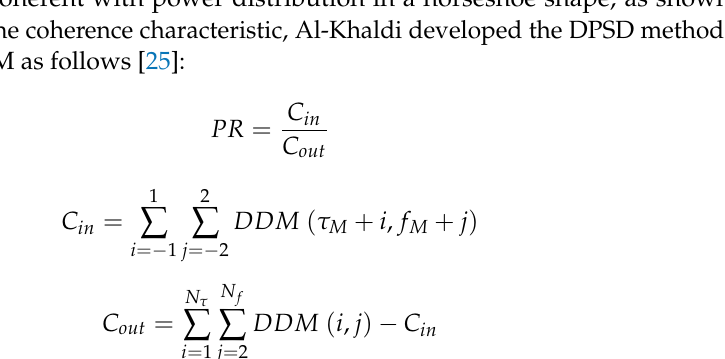
Figure 3. Two distinct DDMs. ( a ) Incoherent DDM. ( b ) Coherent DDM. Note that each DDM is normalized by its maximum